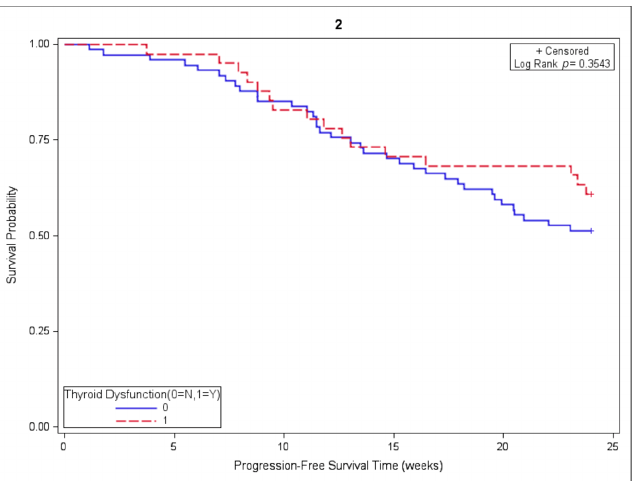
Figure 2. Association of thyroid dysfunction and progression-free survival (PFS).